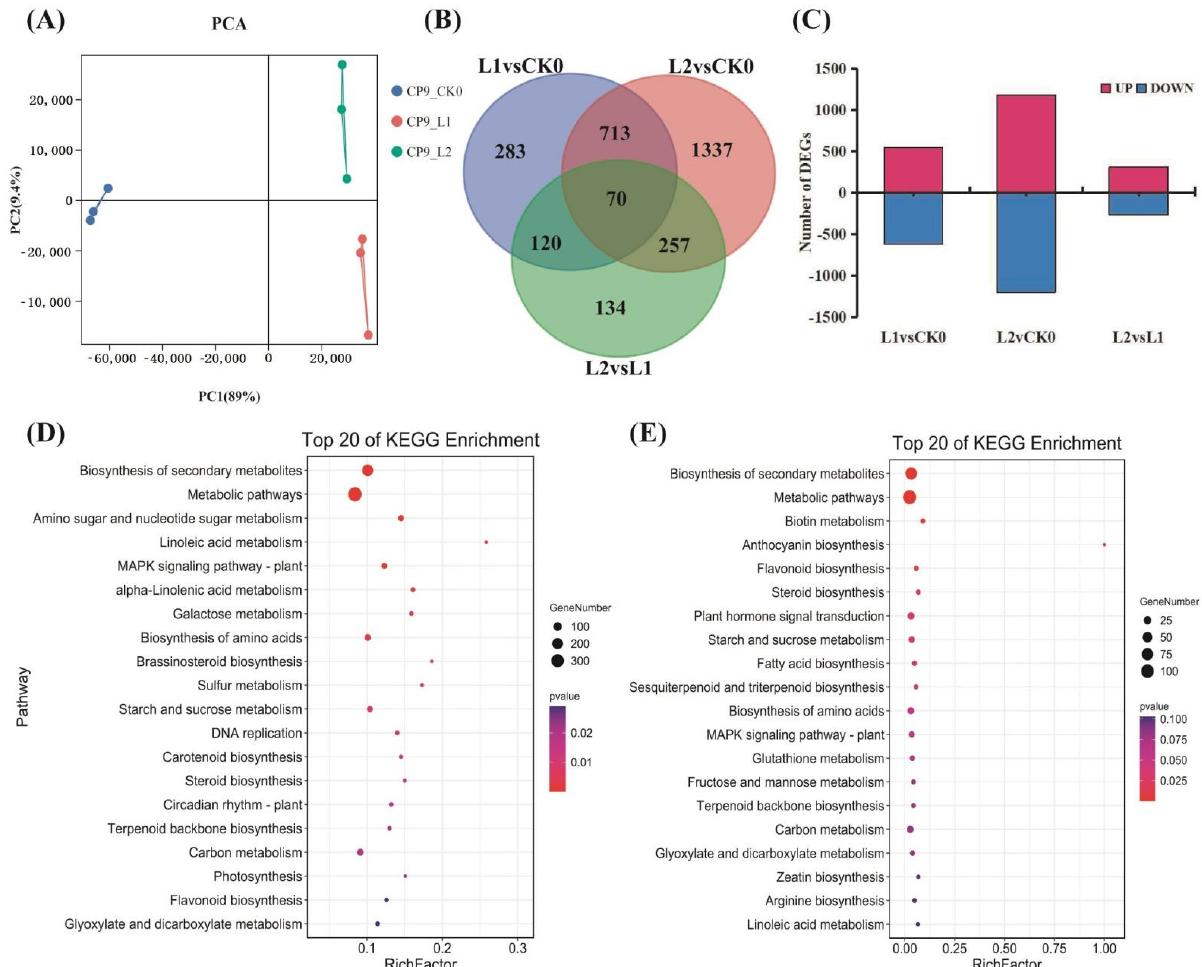
Figure 2. Overview of the RNA–seq data of SH peach fruit stored at room temperature or low temperatures. ( A ) Principal component analysis (PCA) of stony hard (SH) peach fruit during harvest, cold storage, and subsequent ripening. Abbreviations used are as follows: CK0, stored at room temperature for 0 d; L1, stored at 4 °C for 20 d; and L2, stored at 4 °C for 40 d; ( B ) Venn diagrams of DEGs among the different comparison groups (L2 vs CK0, L1 vs CK0, and L2 vs L1); ( C ) Number of DEGs identified by pairwise comparison in the different comparison groups (L2 vs CK0, L1 vs CK0, and L2 vs L1). Up, upregulation; Down, downregulation. Threshold: |Log2FC| ≥ 2, p < 0.05; ( D ) KEGG enrichment analysis of 2914 DEGs; ( E ) KEGG enrichment analysis of 783 DEGs.